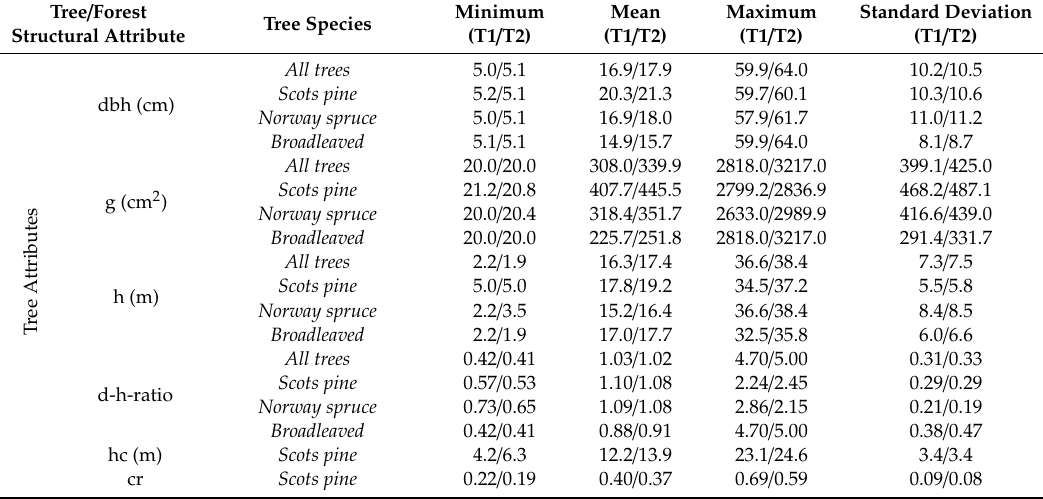
Table 1. Variation in tree attributes by tree species and forest structural attributes by main tree species of a sample plot, measured in 2014 (T1) and 2019 (T2). Diameter at breast height (dbh), basal area (g), tree height (h), diameter-height-ratio (d-h-ratio), height of the crown base (hc), and crown ratio (cr) were defined at tree level whereas basal area-weighted mean diameter (D g ) and -height (H g ), mean basal area (G), and number of trees per hectare (TPH) were defined at plot level. Scots pine-dominated plots = basal area of Scots pine ( Pinus sylvestris L.) accounts for more than 67% of the total basal area of a plot. Norway spruce-dominated plots = basal area of Norway spruce ( Picea abies (L.) H. Karst.) trees account for more than 67% of the total basal area of a plot. Mixed-species plots = basal area of two or more tree species each account for more than 30% of the total basal area of a